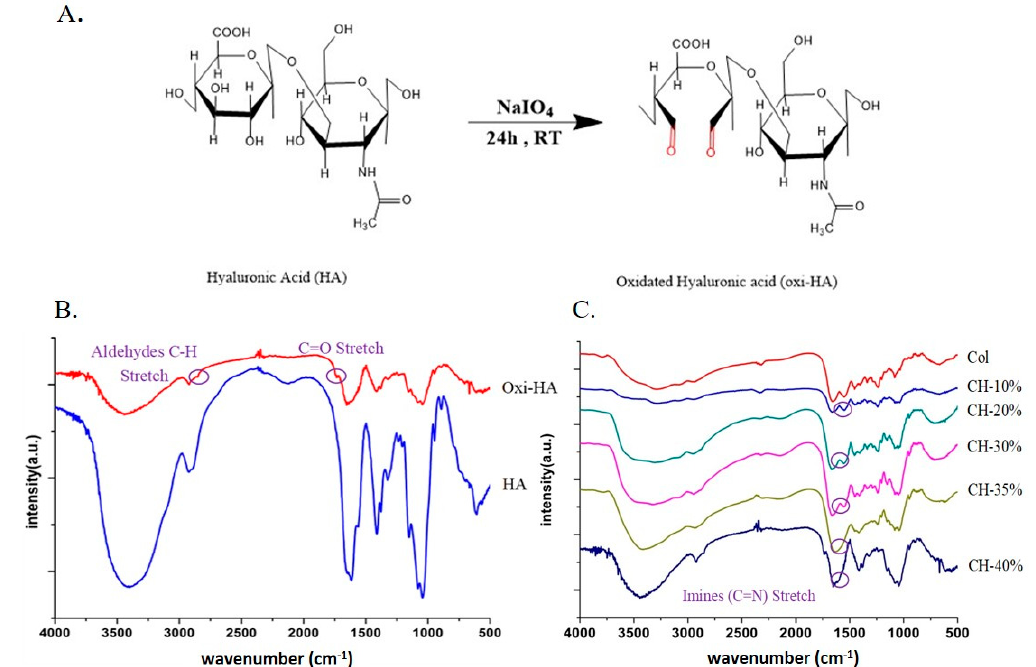
Figure 1. ( A ) Chemical schematic of hyaluronic acid oxidation oxidized by sodium periodate; the newly formed aldehyde group is expressed in red color [37]; ( B ) FTIR Spectra of hyaluronic acid (red) and oxidized hyaluronic acid (blue); and ( C ) collagen (Col) and oxi-HA/collagen (CH) at different weight ratios ( w / w ).